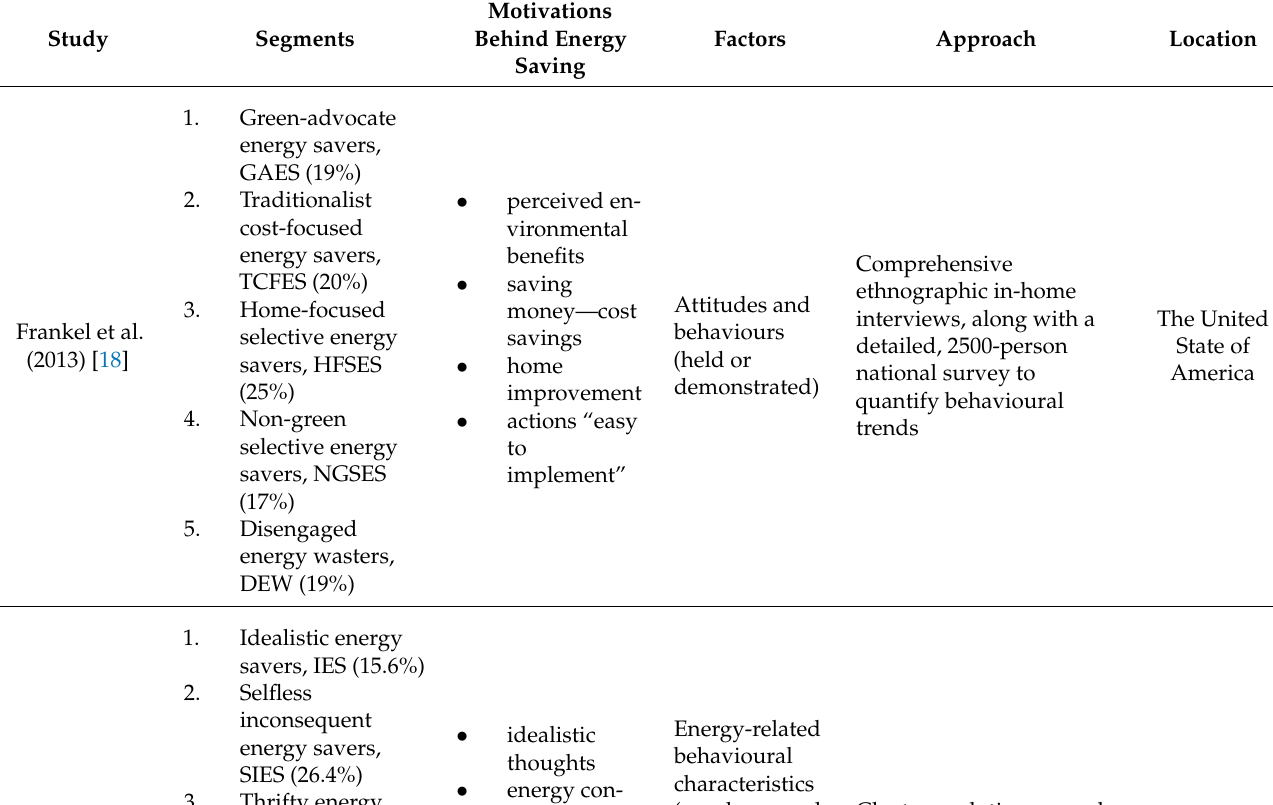
Motivations Behind Energy Factors Approach Location Saving